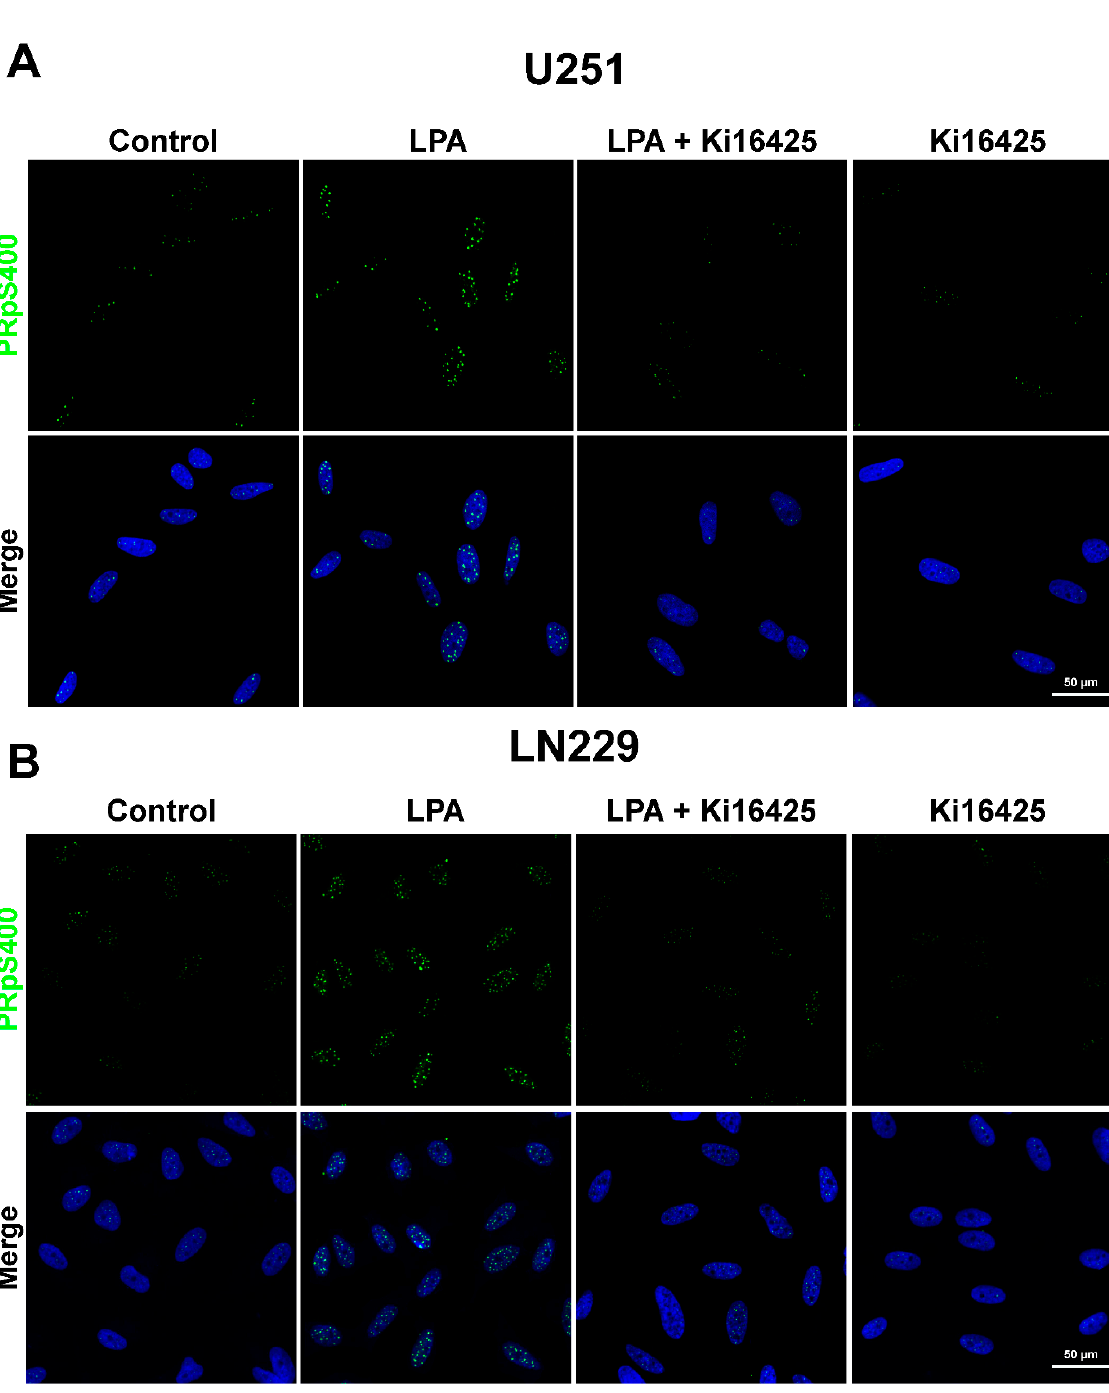
Figure 2. Localization of PRpS400 in GBM cell lines. PRpS400 localization in cell nuclei. The treatment with Ki16425 (2.5 µM) inhibited the effect of LPA (100 nM) on the phosphorylation of PR at S400 at 15 min of stimulation in the GBM cell lines ( A ) U251, ( B ) LN229. PRpS400 (Green puncta), Hoechst (Blue). Representative images from 3 independent experiments. The photographs were taken at 60× magnification.